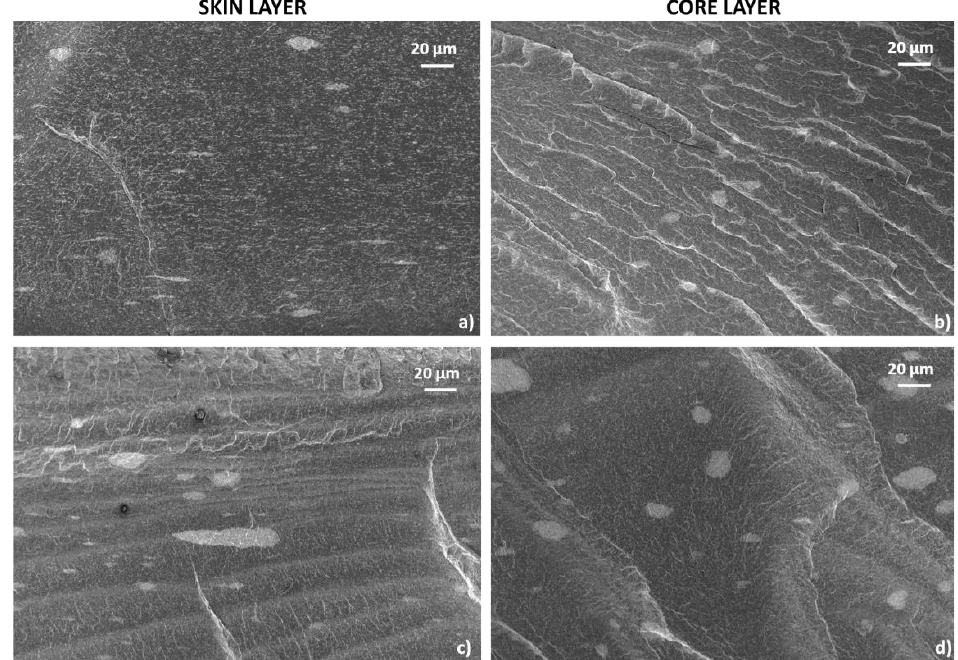
Figure 9. Enlargement of the FESEM images of the cross-section of 3%-MWCNT nanocomposite, as reported in Figure 8. The micrographs were obtained from the skin layers of the nanocomposites manufactured at mold temperature 25 °C ( a ) and 100 °C and ( c ) from the core regions of the nanocomposites manufactured at mold temperature 25 °C and ( b ) 100 °C ( d ), respectively.